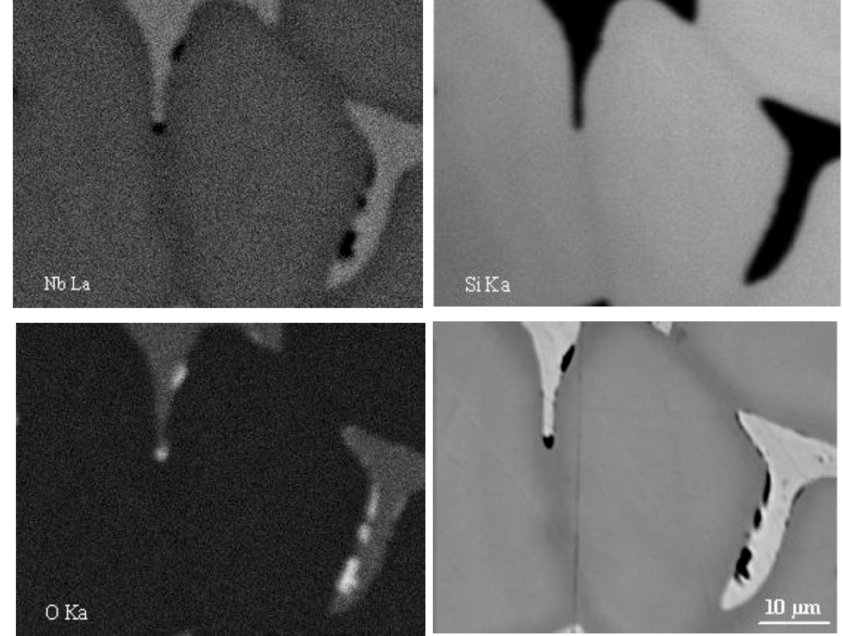
Figure 3. EPMA / Wavelength Dispersive spectroscopy (WDS) X-ray maps from the centre of the cross section of ZF6-HT (1400 ◦ C / 100 h) showing oxygen contamination at the edges of some of Nbss